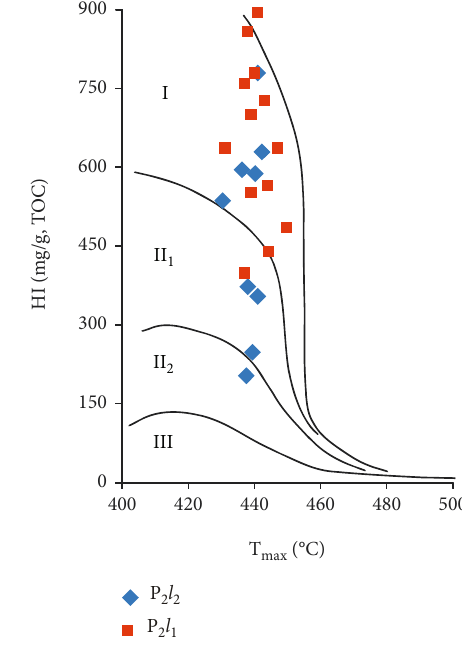
Figure 13: Organic matter types in the upper and lower sweet spots of source rocks in Lucaogou Formation, Jimsar